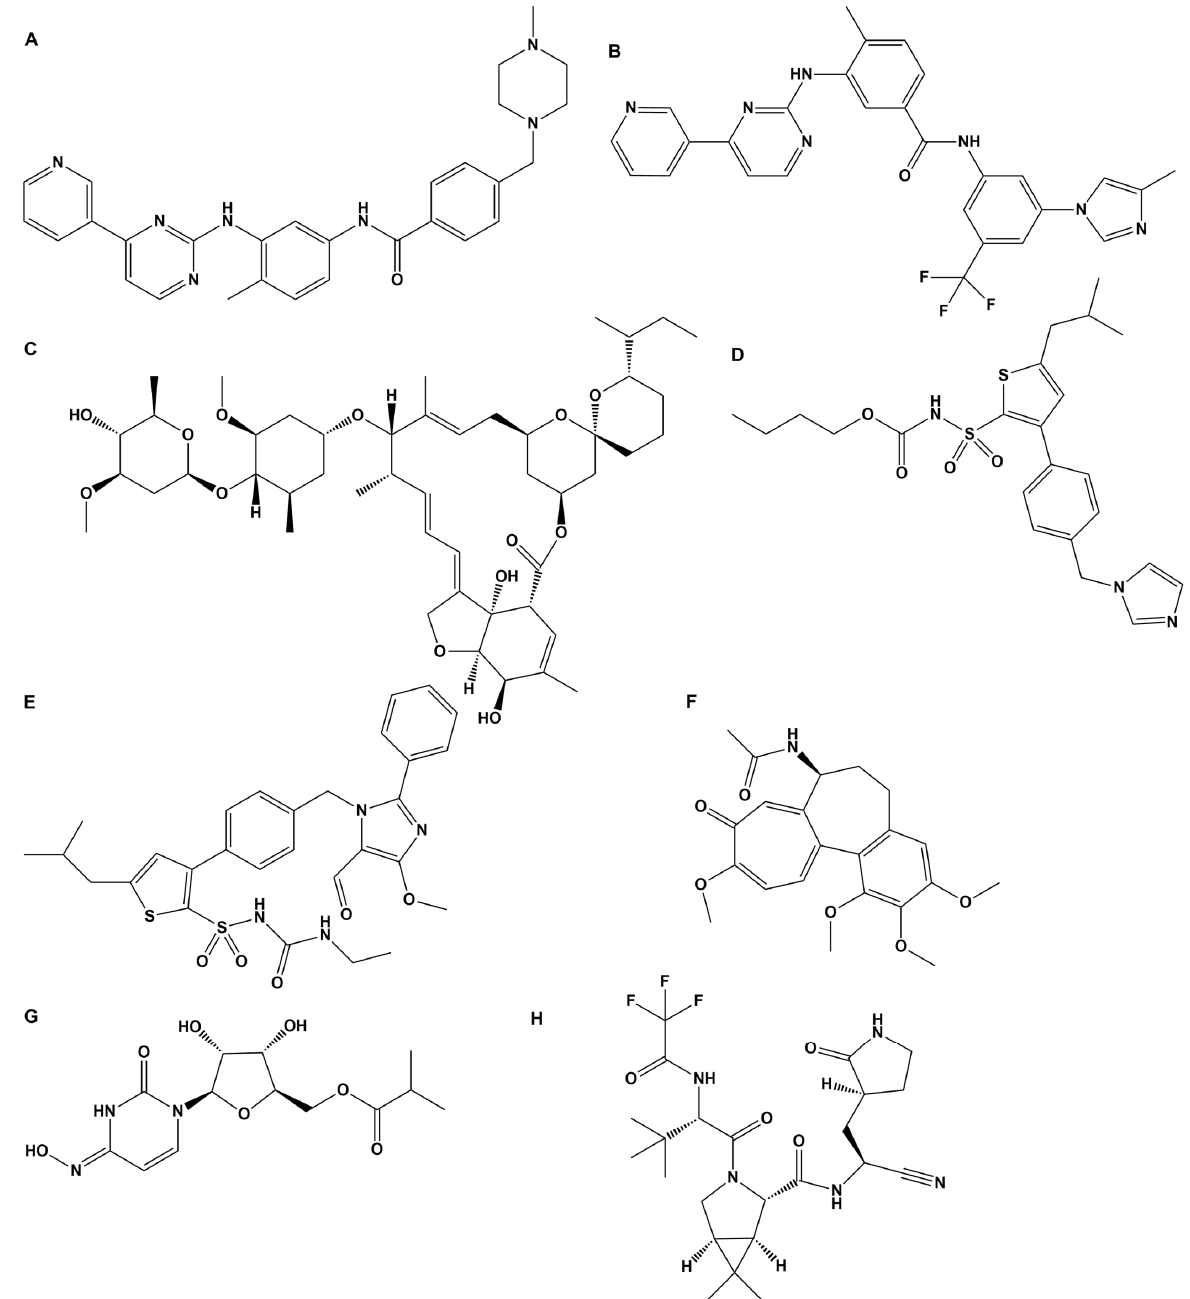
Figure 6. Repurposed and antiviral drugs in the treatment of COVID-19. ( A ) Chemical structure of imatinib. Imatinib is a specific tyrosine kinase receptor inhibitor that is used in the therapy of Philadelphia chromosome-positive chronic myelogenous leukemia and gastrointestinal stromal tumors. In silico studies have shown that losartan and imatinib are effective against SARS-CoV-2. Its functional groups are NH and NH amide between aromatic rings and may work in a similar way to DIZE [71] . ( B ) Chemical structure of nilotinib. Nilotinib is an improved analog of imatinib acting at the receptor in a similar way to DIZE. ( C ) Chemical structure of ivermectin. The FDA-approved drug ivermectin inhibits the replication of SARS-CoV-2 in vitro. The functional groups of ivermectin are the three hydroxyl groups, which may act at the receptor level through their hydroxylates [72] . ( D ) Chemical structure of Compound 21. Compound 21 is a nonpeptide agonist of heptapeptide